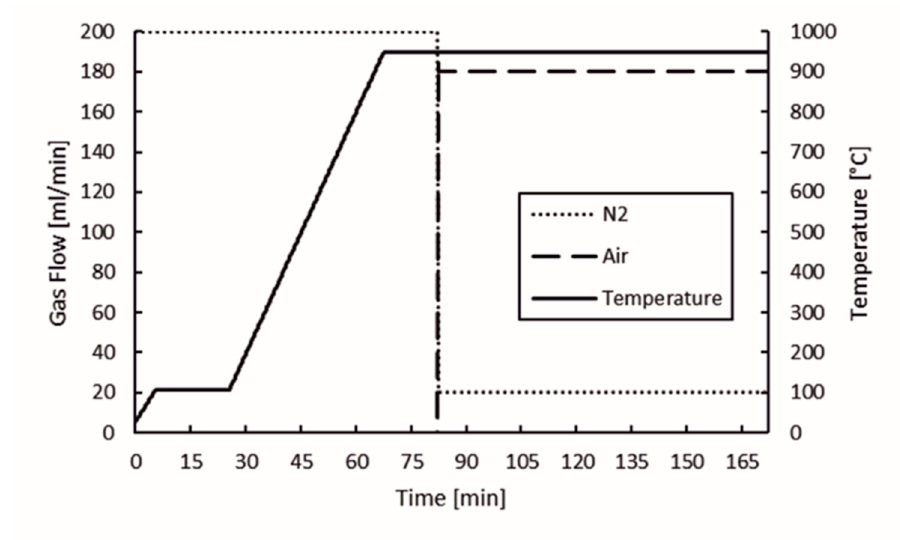
Figure 2. Proximate analysis experimental program.